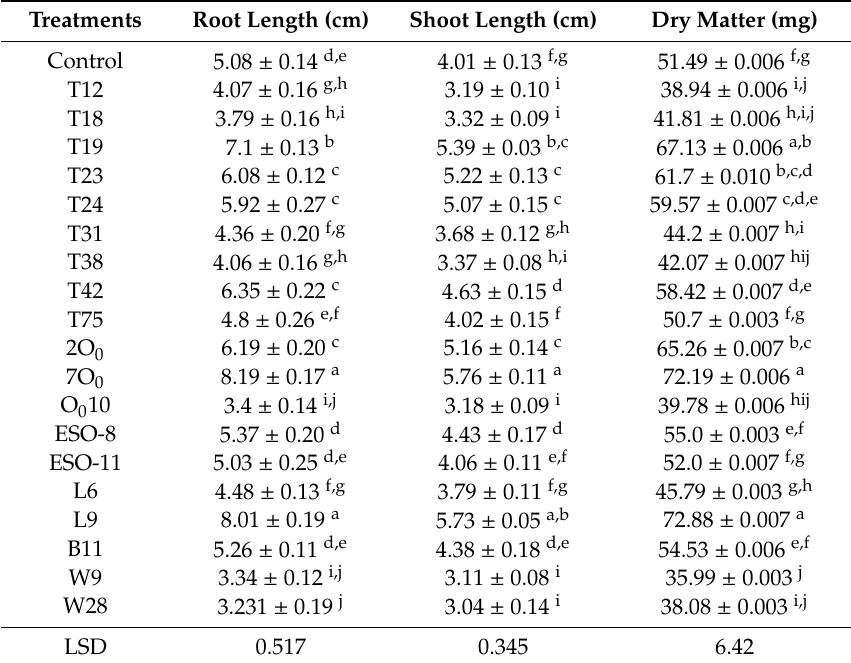
Table 2. The e ff ect of cyanogenic E. coli inhibiting rhizobacteria on lettuce seedlings in agar bioassay. Values sharing the same letter(s) in a column do not di ff er significantly from each other at p < 0.05. Values in a column indicate mean ± standard